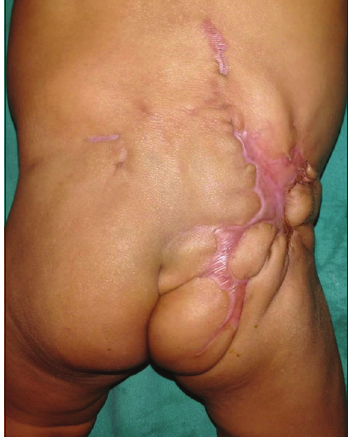
Figure 3: Healed raw area 1 month after applying